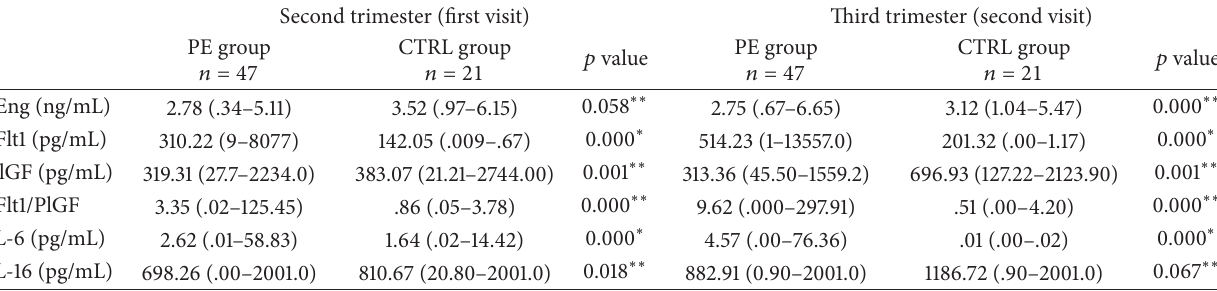
Table 2: Serum levels of soluble markers analysed in PE and controls.